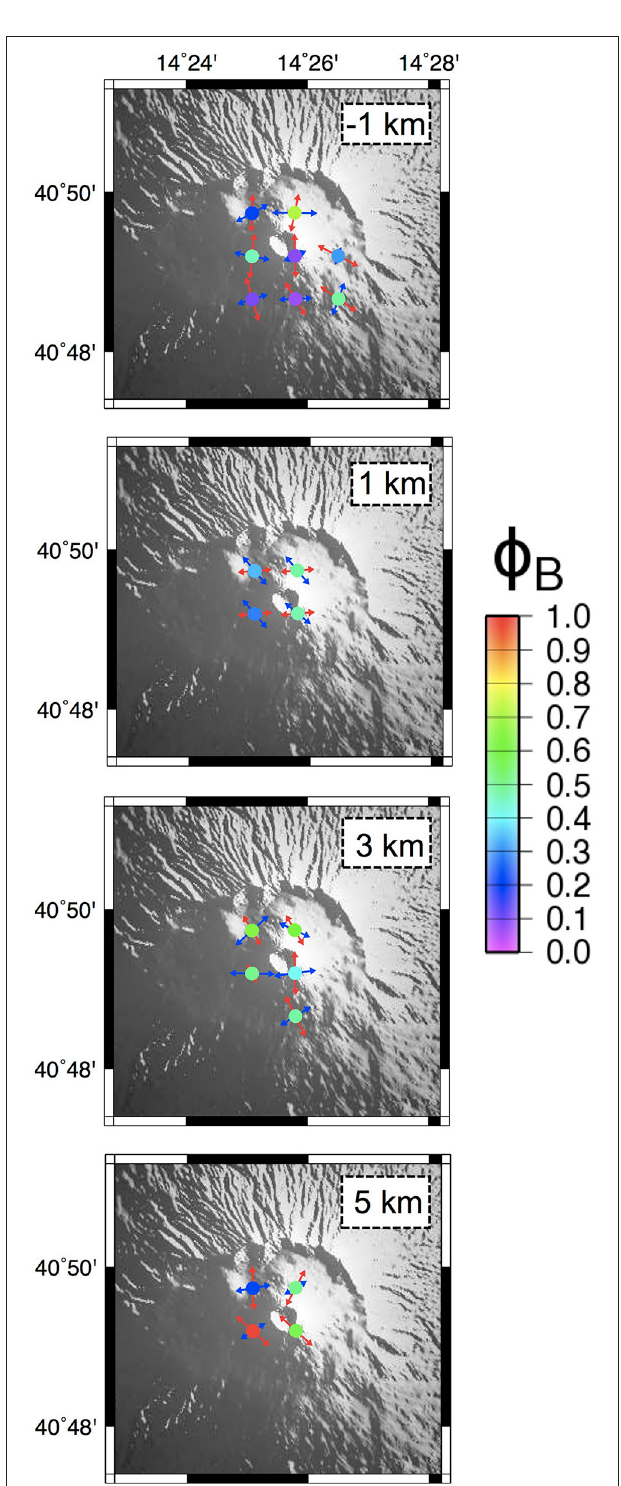
FIGURE 6 | Mt. Somma-Vesuvius. Stress field tensors retrieved from focal mechanisms data using the BRTM. Slices at − 1, 1, 3, and 5km-depth. Stress tensors have been computed over a regular grid of 1-km spacing, considering only nodes containing at least five FPSs. σ 1 and σ 3 axes are plotted as pairs of respectively red-blue arrows. The color of the circles corresponds to the retrieved 8 B value for each node (see scale on the